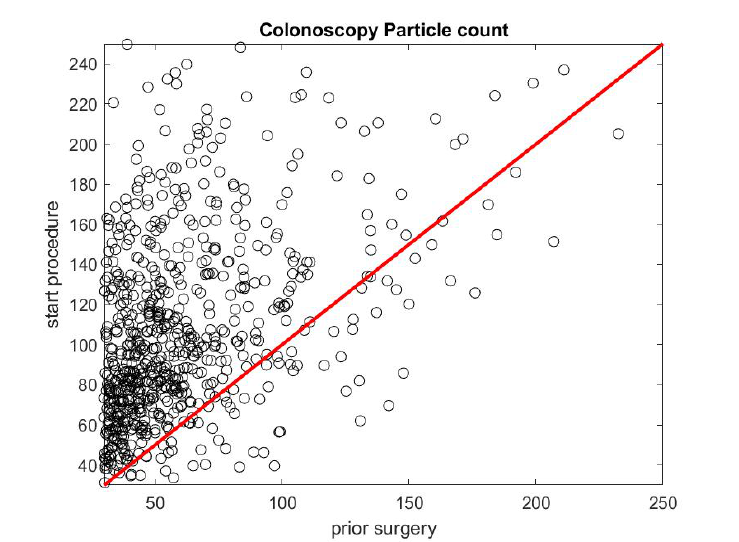
Figure 5. Particle count during the first 5 min of a colonoscopy D start versus particle count during the 5 min prior to the procedure D pre .